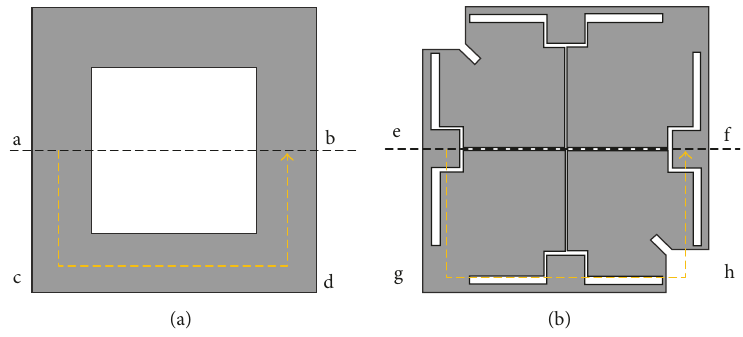
Figure 5: The comparison of loop antenna and the proposed antenna (not in scale).